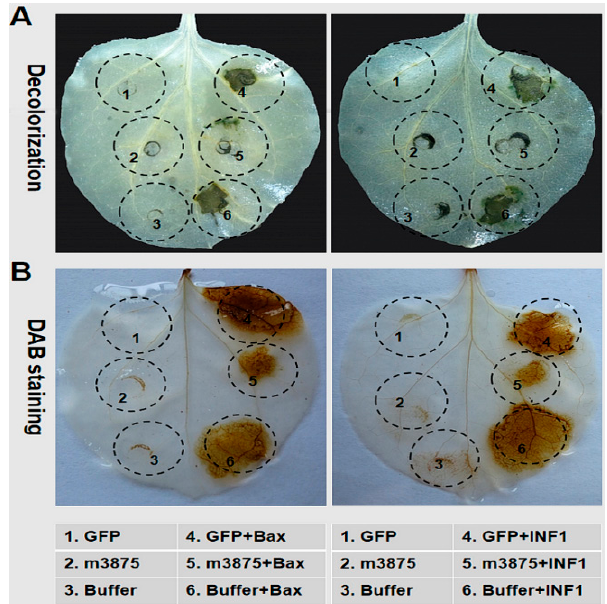
Figure 3. Suppression of PCD by m3875. ( A ) The m3875 suppressed both BAX- and INF1-triggered cell death in Nicotiana benthamiana . The N. benthamiana leaves were infiltrated with inoculation buffer or Agrobacterium tumefaciens cells expressing m3875 or green fluorescent protein (GFP), either alone or followed 24 h later with A. tumefaciens cells carrying the BAX or INF1 gene. The leaves were subjected to decolorization with ethanol and visualized 5 days after BAX- or INF1- infiltration. ( B ) m3875 inhibited BAX- and INF1-induced H 2 O 2 accumulation in N. benthamiana . Infiltration was performed as described above, and the leaves were detached at 2 days after BAX- or INF1- infiltration for 3,3 ′ -diaminobenzidine (DAB) staining.